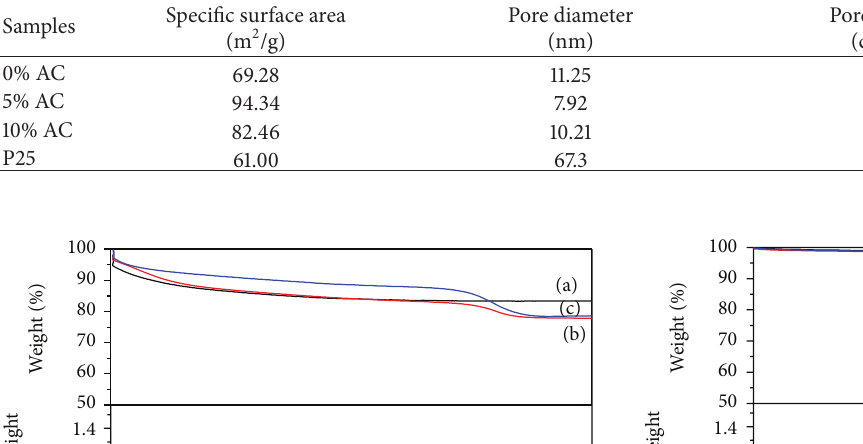
Table 1: Physical properties of P25 Aeroxide TiO